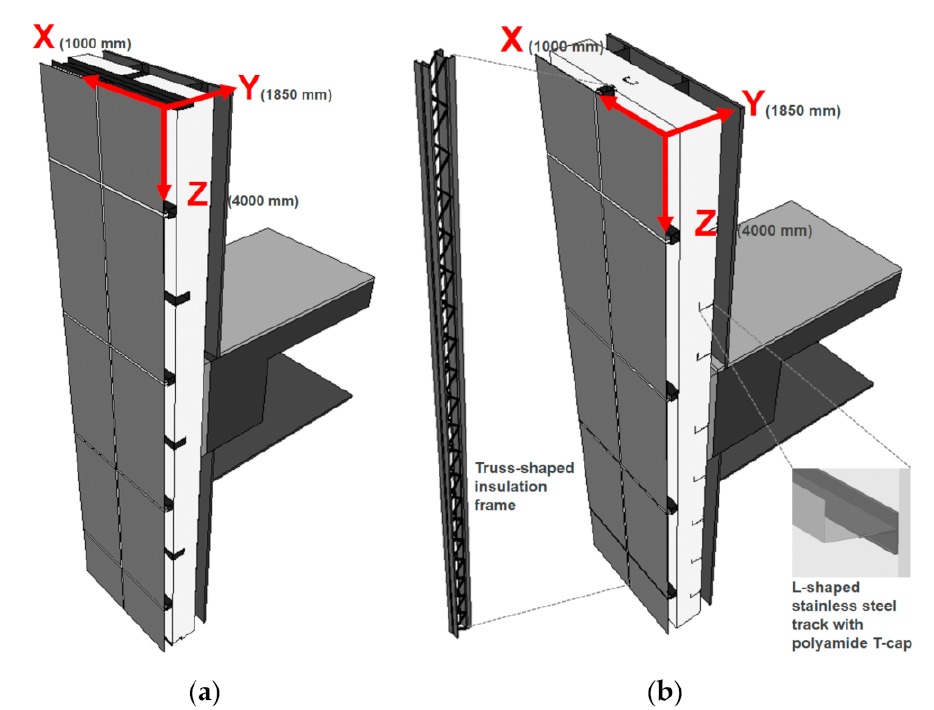
Figure 9. Three-dimensional geometric models in Physibel Trisco: ( a ) base case; ( b ) alternative